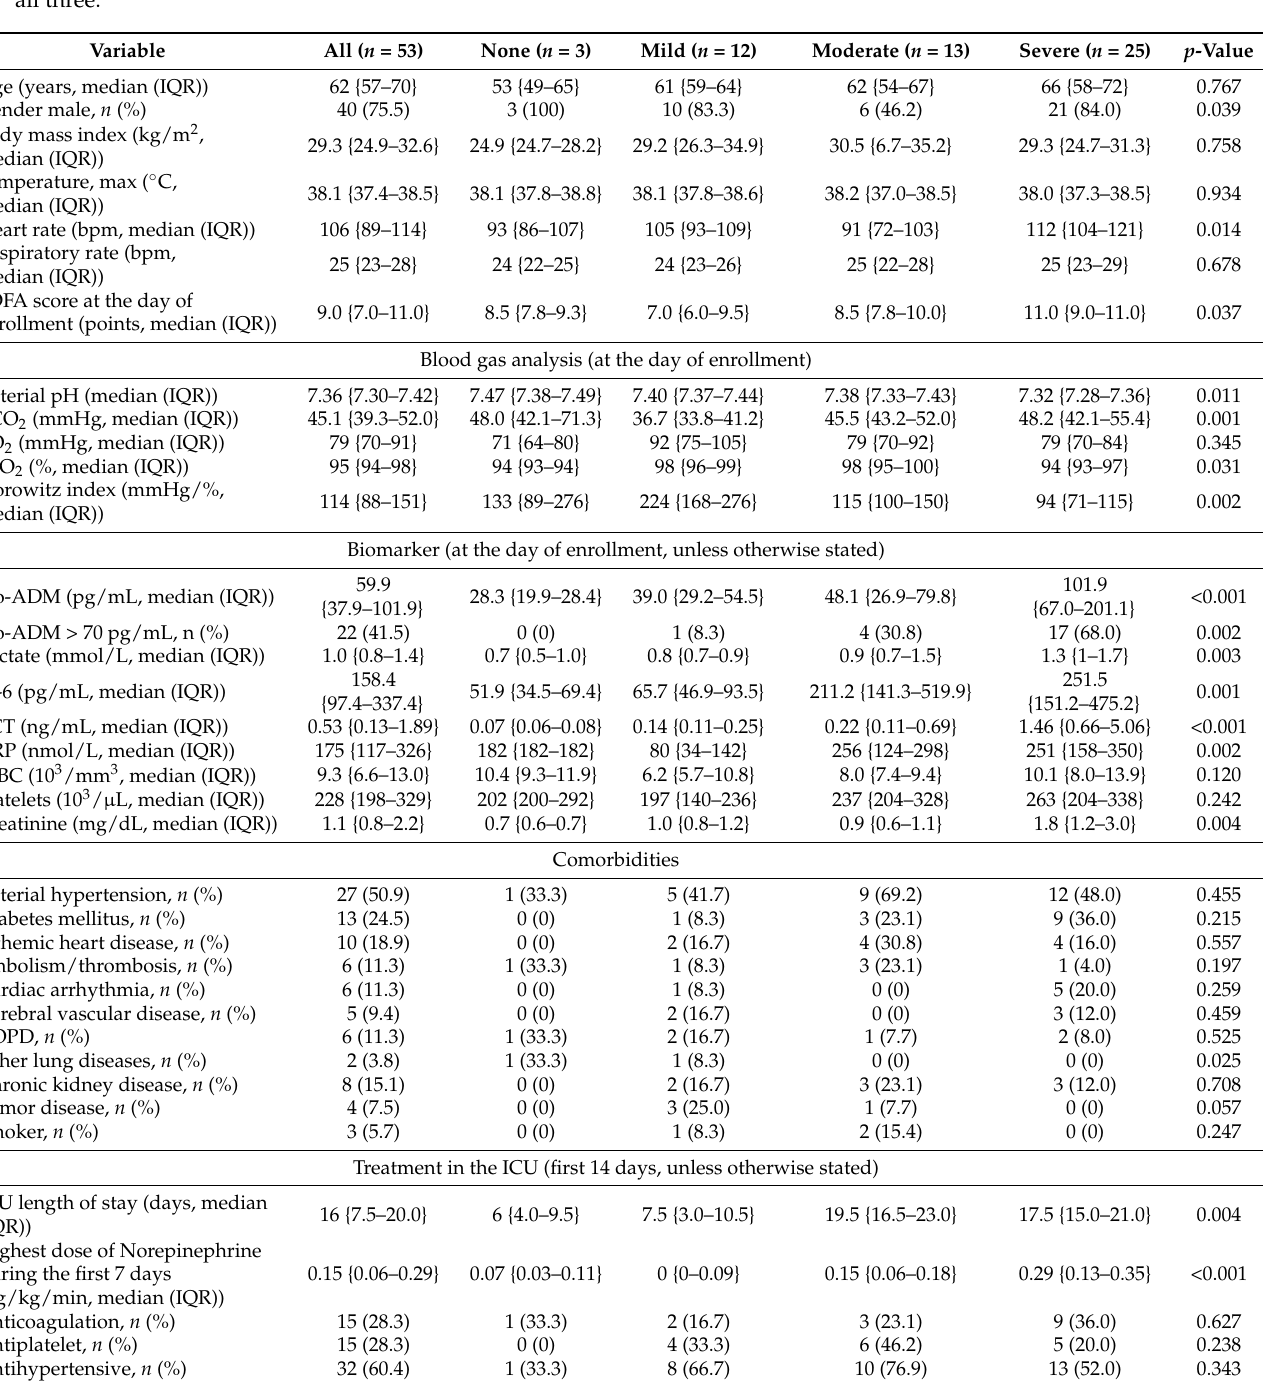
Table 1. The baseline characteristics of 53 critically ill COVID-19 patients stratified by the severity of ARDS. The variables in the outcome section of Table 1, intubation and status on day 28, have three categories each, and the p -value compares all